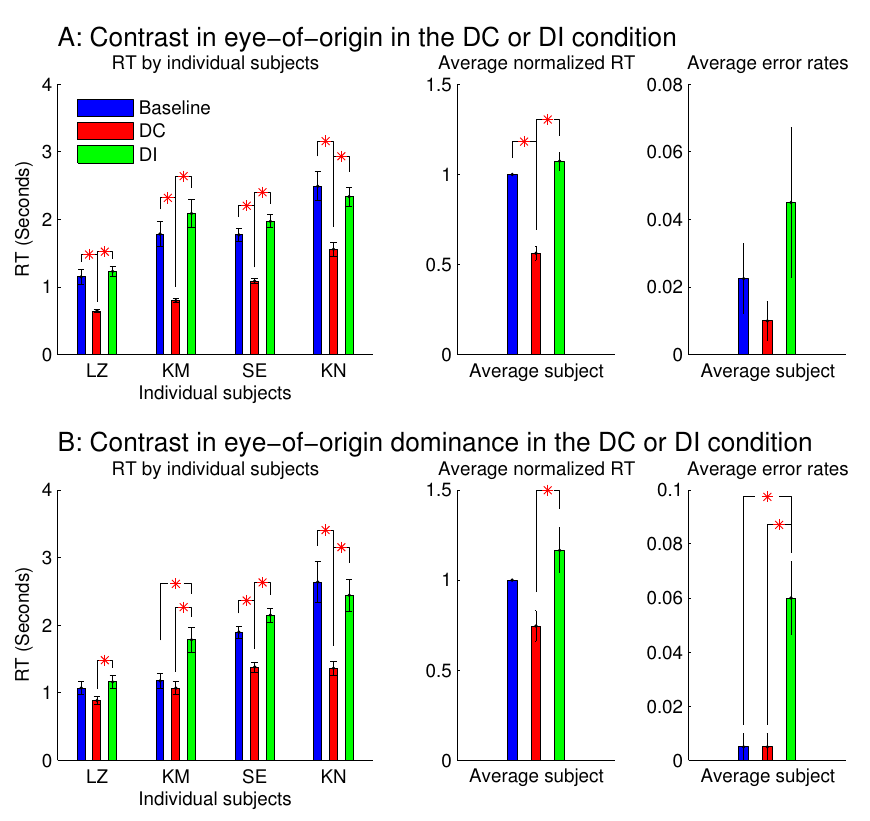
Figure 3. Reaction times (in button press responses) and error rates (the number of incorrectly responded trials as a fraction of the number of all the trials in a given condition) in the task to search for a uniquely oriented bar in a background of uniformly oriented bars (all bars were tilted 10 deg, clockwise or anti-clockwise from horizontal). Stimuli were displayed on a CRT, viewed by a pair of stereo goggles. The attentional capture by the eye-of-origin singletons ( A ) is extended to the capture by the singletons in eye-of-origin dominance ( B ). In the latter, for all the bars, the input contrast to the input-dominant eye was nine times that to the other eye (i.e., s L = 9 s R or s L = s R /9). For (B), each search item had a random disparity within a range of ( 0.3 ◦ ,0.3 ◦ ) , except for the zero-disparity − items in the left-most and right-most columns of the search array. In each figure of this paper, all error bars mark the standard errors of the means, and a red ‘*’ linking two data bars indicates a significant difference ( p < 0.05) between the two linked data